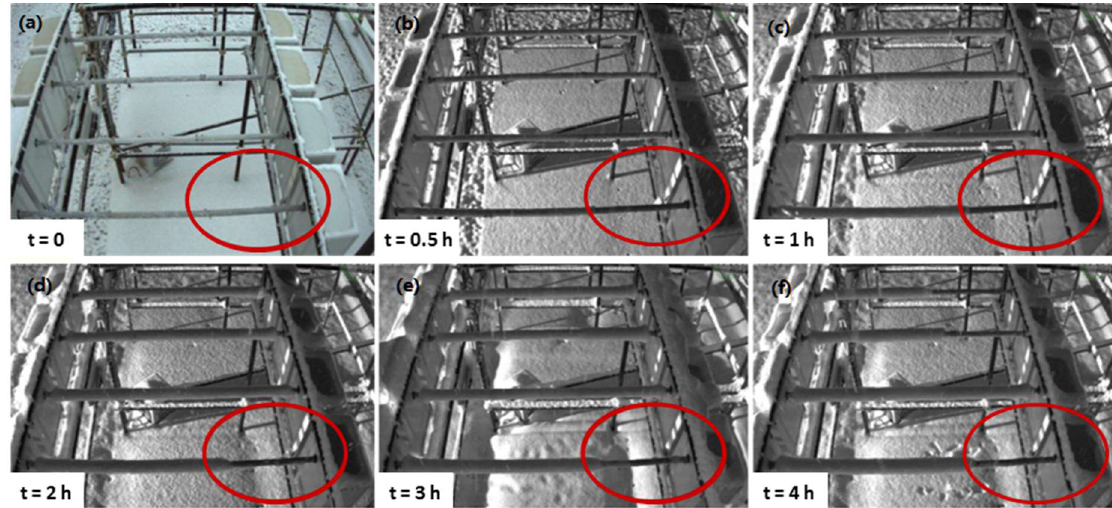
Figure 11. Pictures of coated cables exposed under snowfall condition in outdoor test facility. The red circle highlighted the sandblasted, LF-coated cable with no snow accumulation. Starting time (t = 0) was established when the snowfall began. ( a ) t = 0; ( b ) t = 0.5 h; ( c ) t = 1 h; ( d ) t = 2 h; ( e ) t = 3 h; ( f ) t = 4 h.